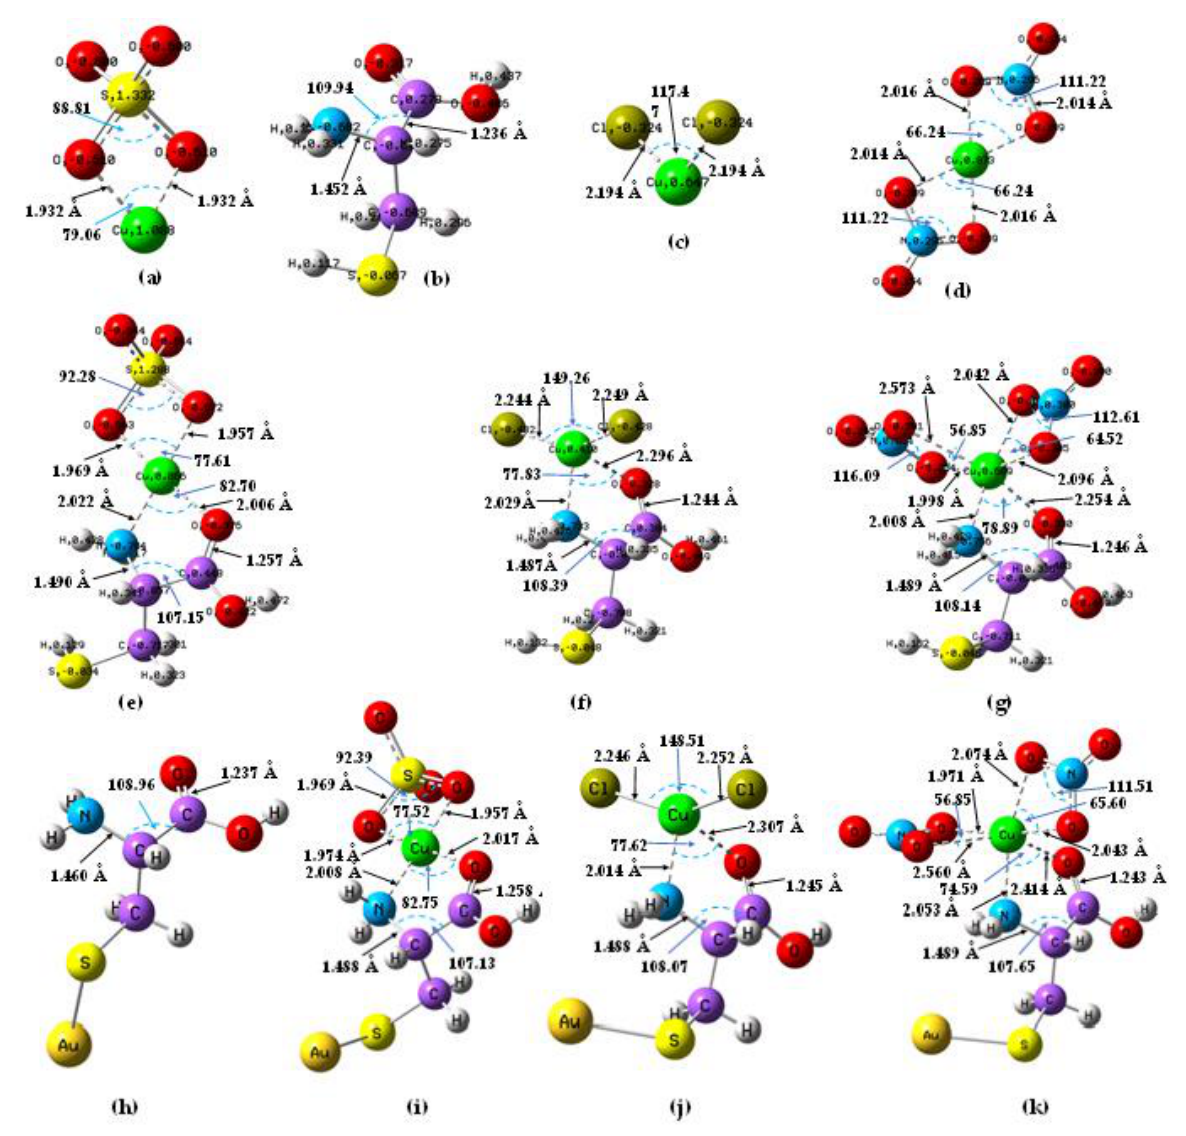
Figure 4. The optimized ball-and-stick molecular structures of ( a ) CuSO 4 ; ( b ) LC; ( c ) CuCl 2 ; ( d ) Cu(NO 3 ) 2 ; ( e ) LC ⊃ CuSO 4 ; ( f ) LC ⊃ CuCl 2 ; ( g ) LC ⊃ Cu(NO 3 ) 2 ; ( h ) [LC−Au]; ( i ) [LC−Au] ⊃ CuSO 4 ; ( j ) [LC−Au] ⊃ CuCl 2 ; and ( k ) [LC−Au] ⊃ Cu(NO 3 ) 2 at the ω B97XD/LANL2DZ level of theory in water solvent system. Color code: carbon = purple, nitrogen = blue; oxygen = red; copper = green; chlorine = yellow-green; sulfur = yellow; gold (Au) = orange; and hydrogen atoms = white. The DFT analysis shows that the closest distance for the CuSO 4 complex is with LC via the bidentate − N,O coordination mode and has the closest distance when compared with the corresponding distances for the LC with Cu(NO 3 ) 2 ) and CuCl 2 . The central Cu 2+ has three nearest oxygen atoms and one nearest nitrogen atom at 1.963 ± 0.009 Å (Cu 2+ − O=S< for coordination with SO 42 − ); 2.006 Å (Cu 2+ − O=C< for coordination with LC) and 2.022 Å (Cu 2+ − NH 2 for coordination with LC), respectively, for the CuSO 4 complex with LC. This finding is consistent with the fact that CuSO 4 has higher electronic binding interaction energies (ΔIE) and Gibbs interaction energies (ΔG) with LC than both Cu(NO 3 ) 2 ) and CuCl 2 (summarized in Tables 2 and 3).